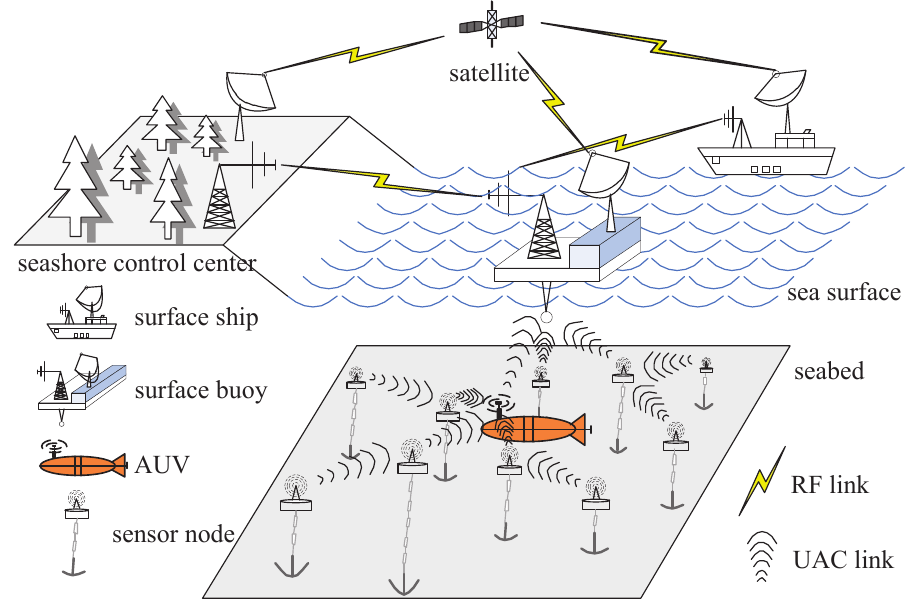
Figure 1. An application of 3D UASN for ocean